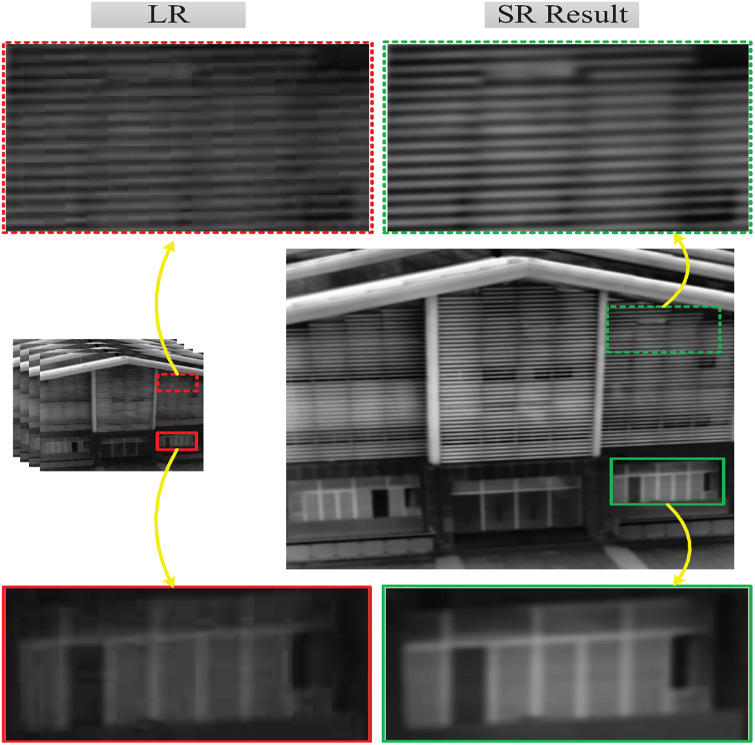
Experimental result of Target 2.